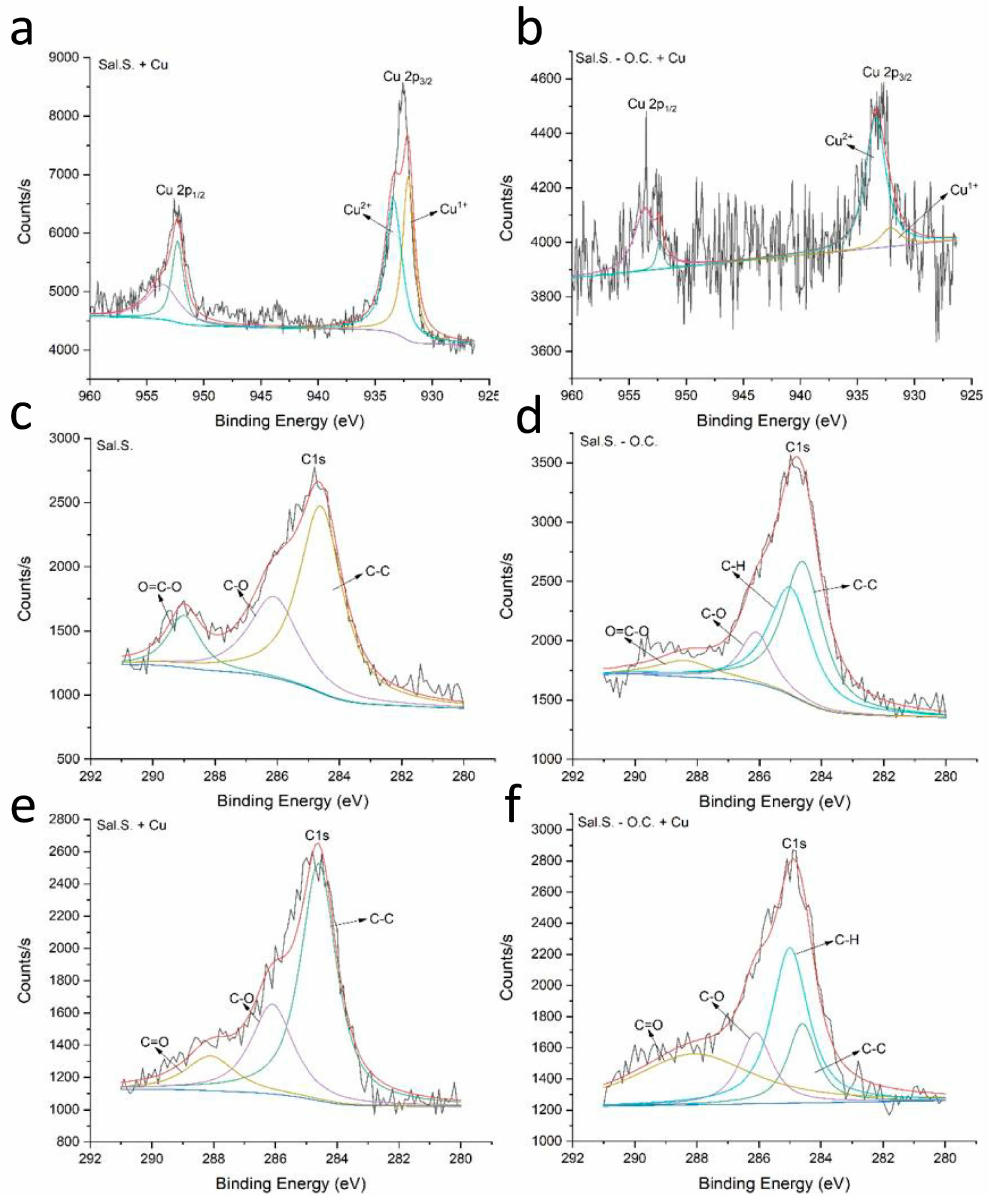
Figure 7. The XPS spectra of C 1s and Cu 2p ( a , b ) from the surface of SASs (Sal.S.) ( c ) and adsorption Cu (Sal.S. + Cu) ( d ), remove organic matter (Sal.S.-O.C.) ( e ) and adsorption Cu after removing organic matter (Sal.S.-O.C. + Cu) ( f ).